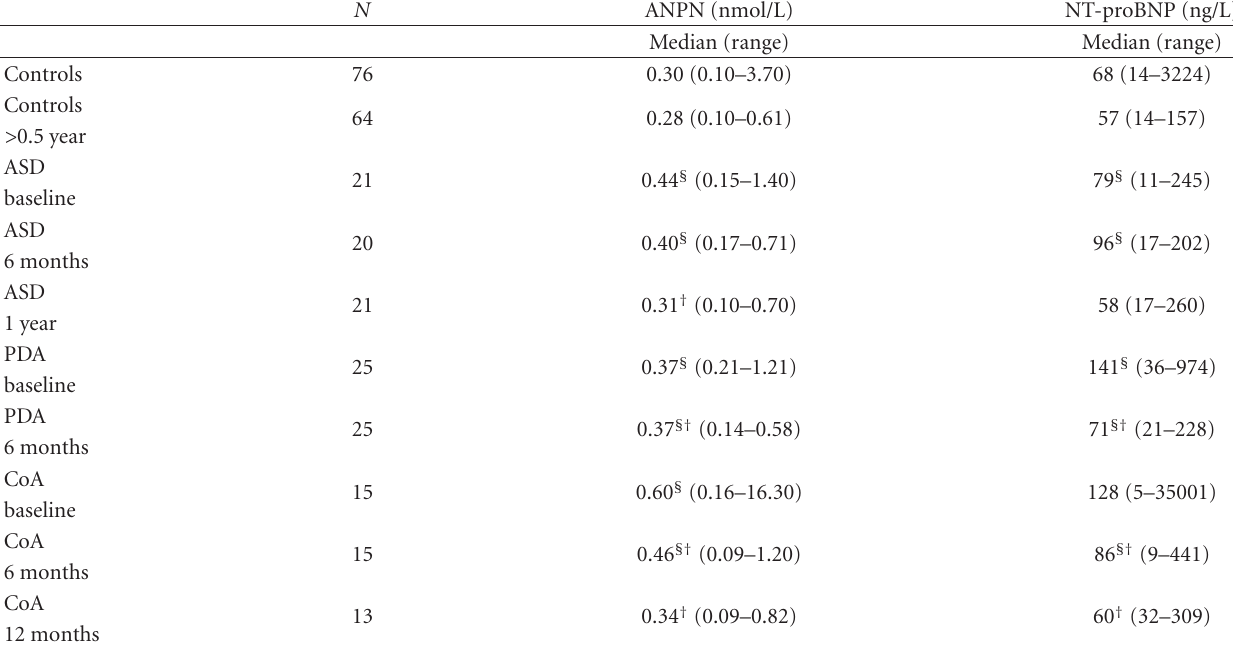
Table 2: Serum levels of ANPN and NT-proBNP in patients measured at baseline and at 6 and 12 months’ follow-up, and in controls. Values are expressed as median